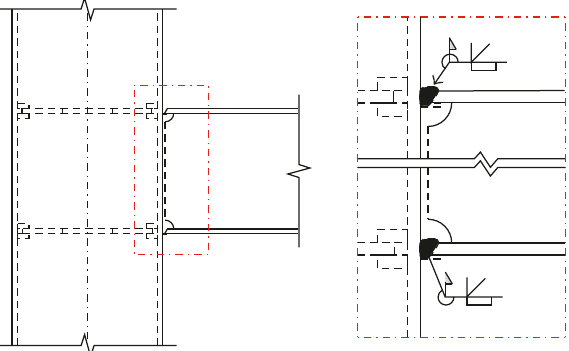
Figure 8: Weld of the beam-to-column connection.